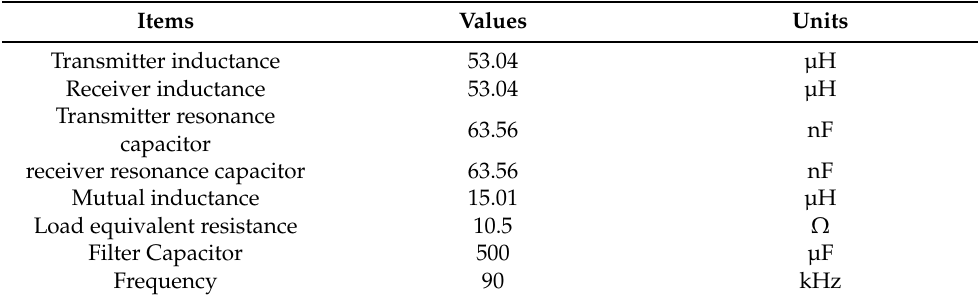
Table 7. Electrical parameters of the designed WPT system.